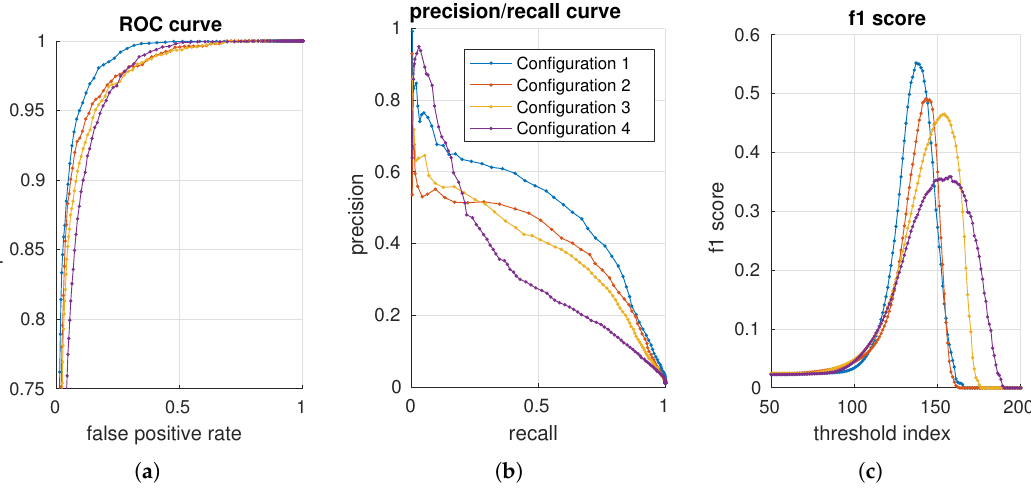
Figure 11. Illustration of an ROC curve ( a ), a precision/recall curve ( b ) and f1 scores ( c ) for four